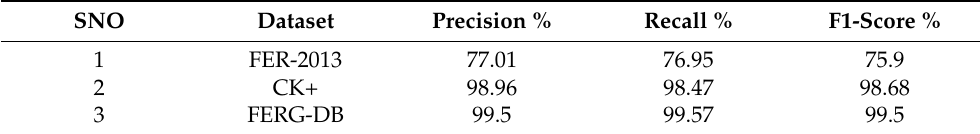
Table 5. Precision, recall and F1-score values on the three datasets.